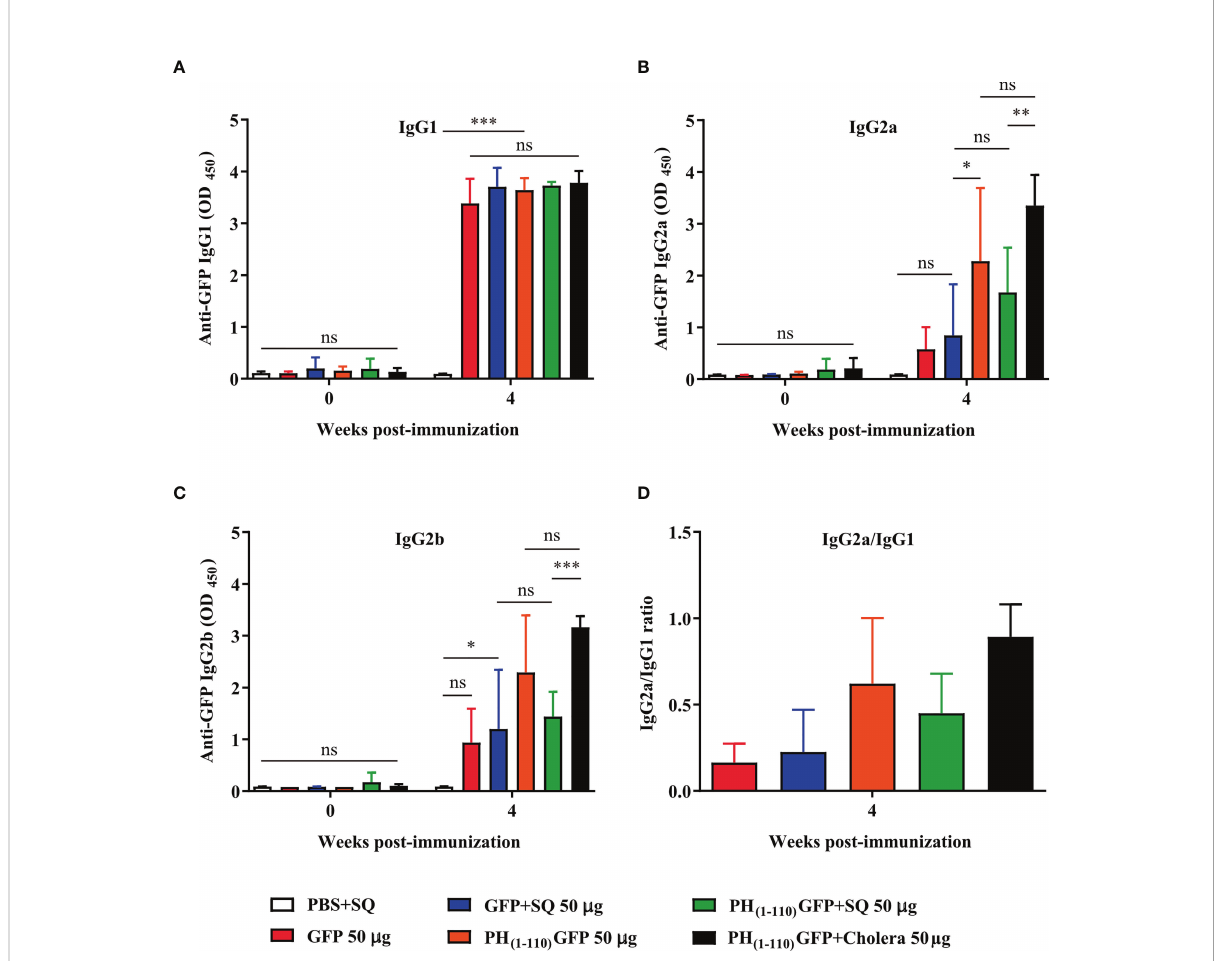
FIGURE 6 Nasal immunization with PH (1-110) GFP NPs favors the Th2 response. Two weeks (week 4) after the last administration of the PH (1-110) GFP NPs and GFP treatments, the pro fi le of immunoglobulin G subtypes was evaluated; IgG1 (A) , IgG2a (B) , and IgG2b (C) . IgG isotypes were measured by ELISA assay. (D) The IgG2a/IgG1 ratio was evaluated in each group to determine the presence of Th1, Th2 or both responses. Data represent mean ± SD (n = 4). The p values were determined by Two-way ANOVA with Tukey post-tests. * p < 0.033; ** p < 0.002; *** p < 0.001; ns = not signi fi